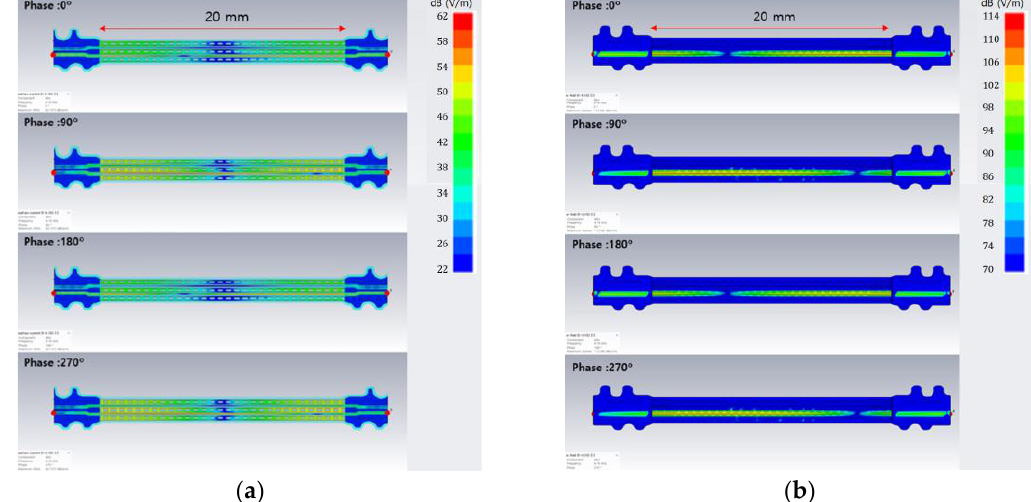
Figure 10. Electric field simulation results using a CST MWS simulator. ( a ) Electric field simulation of Type B and Type C structures with shielding ground as a solid shape and ( b ) Electric field simulation of Type D structure with shielding ground as a meander shape.